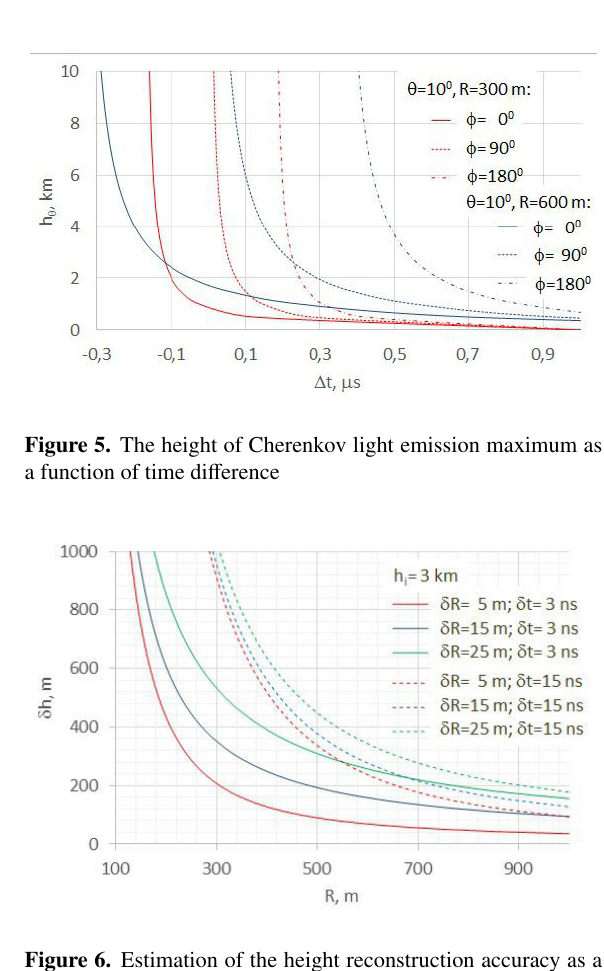
Figure 6. Estimation of the height reconstruction accuracy as a function of the shower core Figure 3. Zenith angle distribution of the shower fraction de-